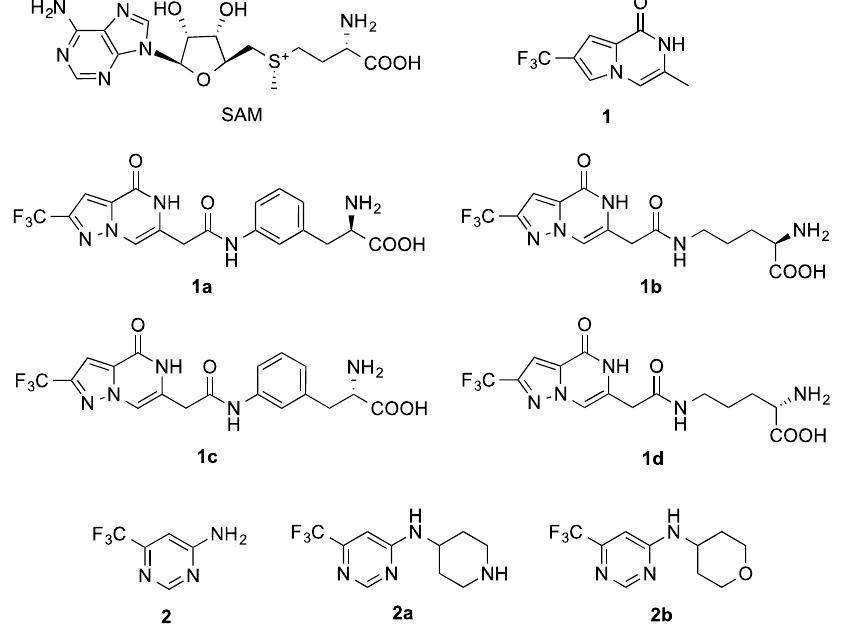
Figure 4. Chemical structures of ligands shown to bind at the cofactor site of hFBL.